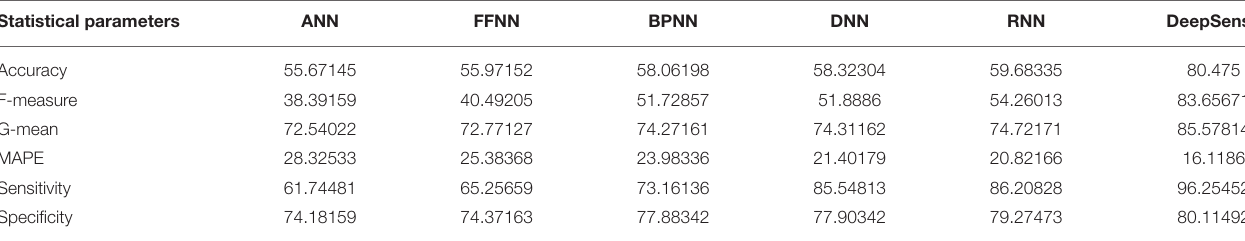
TABLE 1 | Results of statistical parameters for IEEE8023 with 70% training data on 1,000 images. Statistical parameters